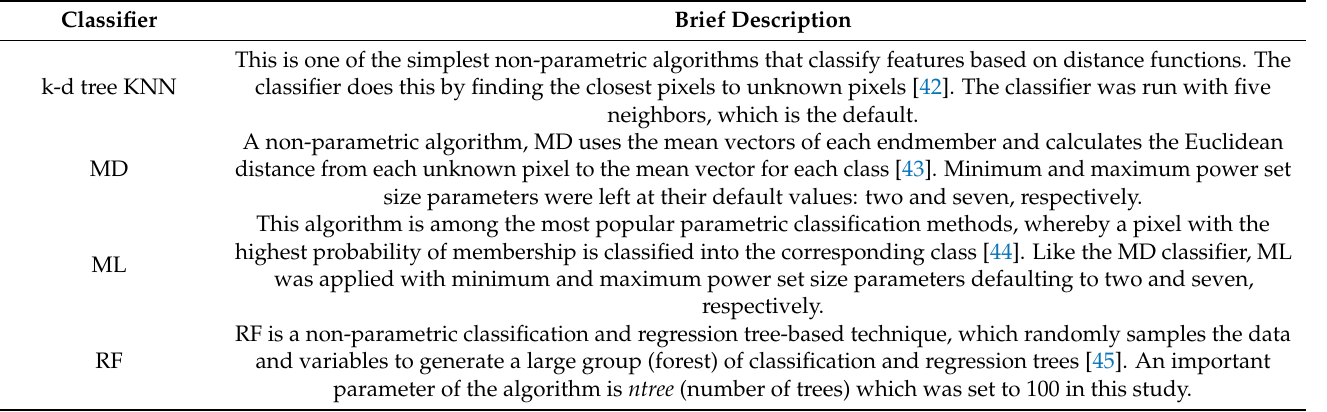
Figure 2. Ground truth points distributed across the study area: ( a ) Google Earth and ( b ) aerial photograph (ArcGIS Online). Table 1. Description of the classifiers used (k-d tree KNN: k-dimensional tree k-nearest neighbor, MD: minimum distance, ML: maximum likelihood, RF: random